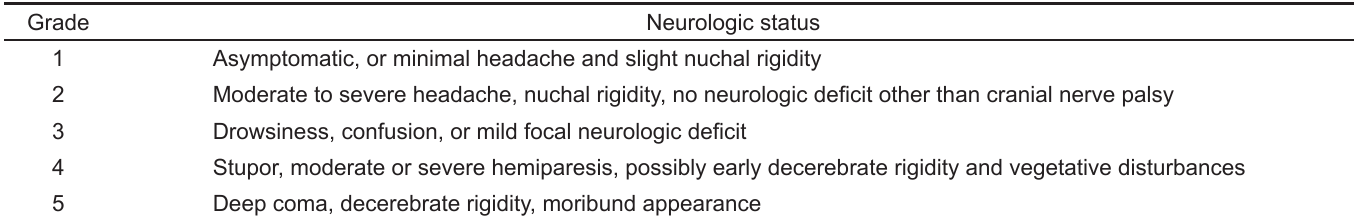
Table 1. Hunt and Hess classification for grading patients with subarachnoid hemorrhage. 9